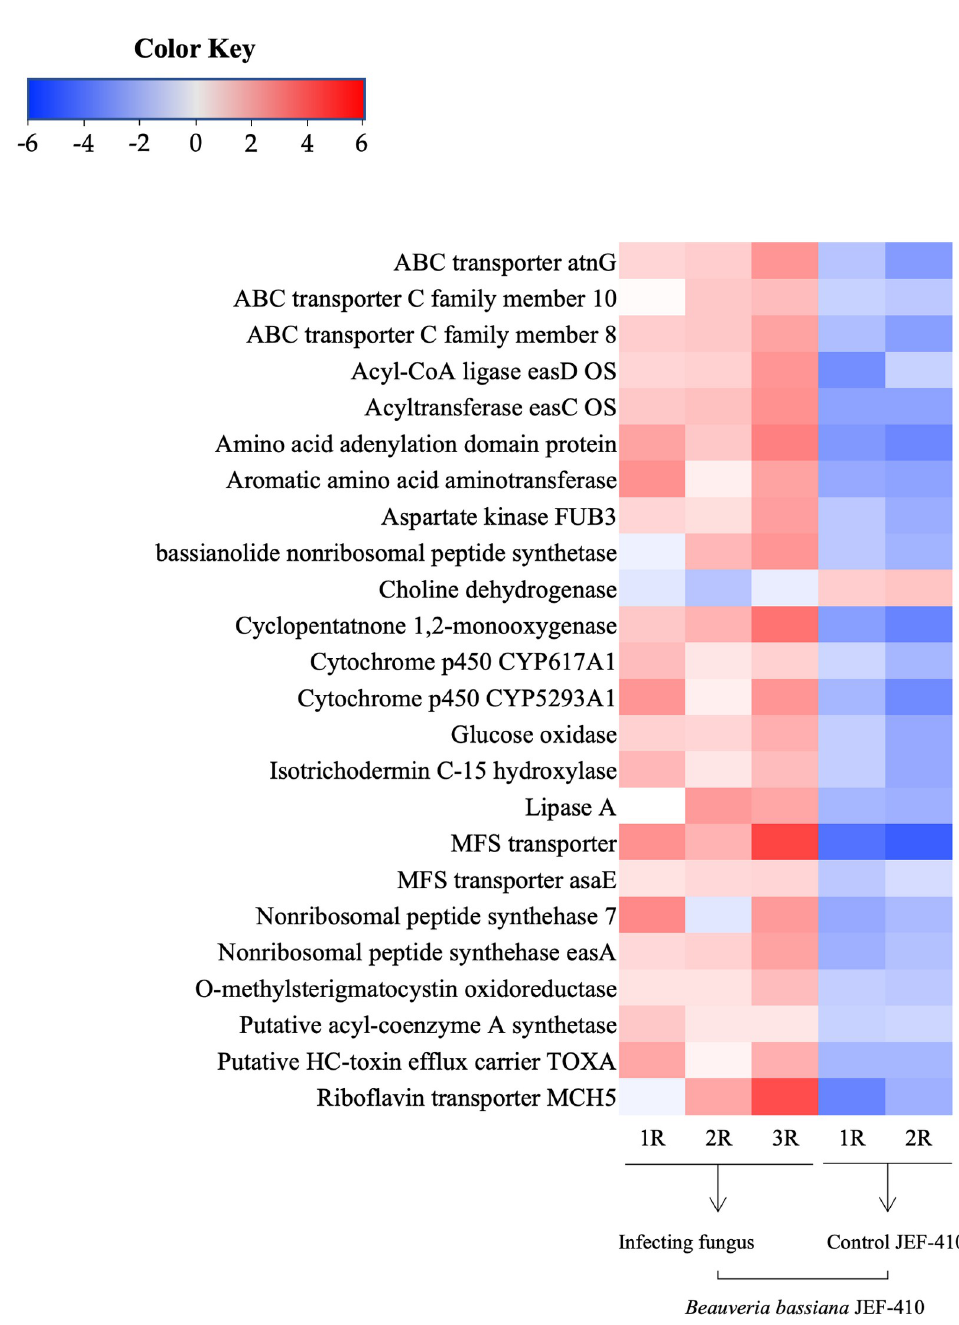
Fig 5. Heatmap of fungal metabolite-related genes. Heatmap of secondary metabolite-related genes of B . bassiana JEF- 410 by significant genes annotated with e-values lower than 1E-50.